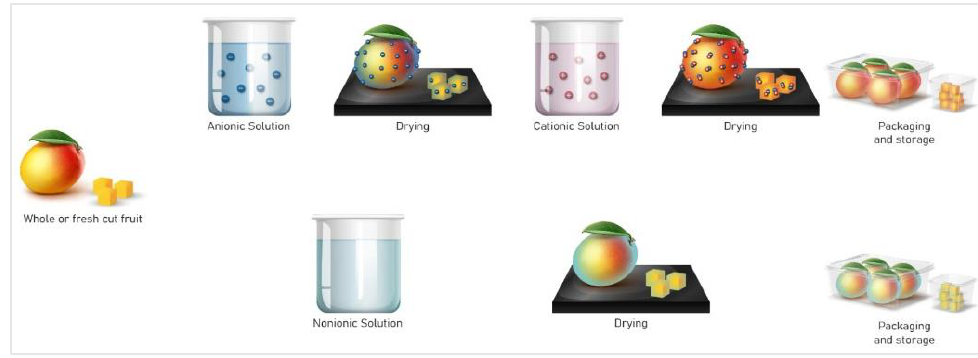
Figure 1. Principal steps involved in mono and bilayer chitosan (CS)-based edible coatings in whole and fresh-cut